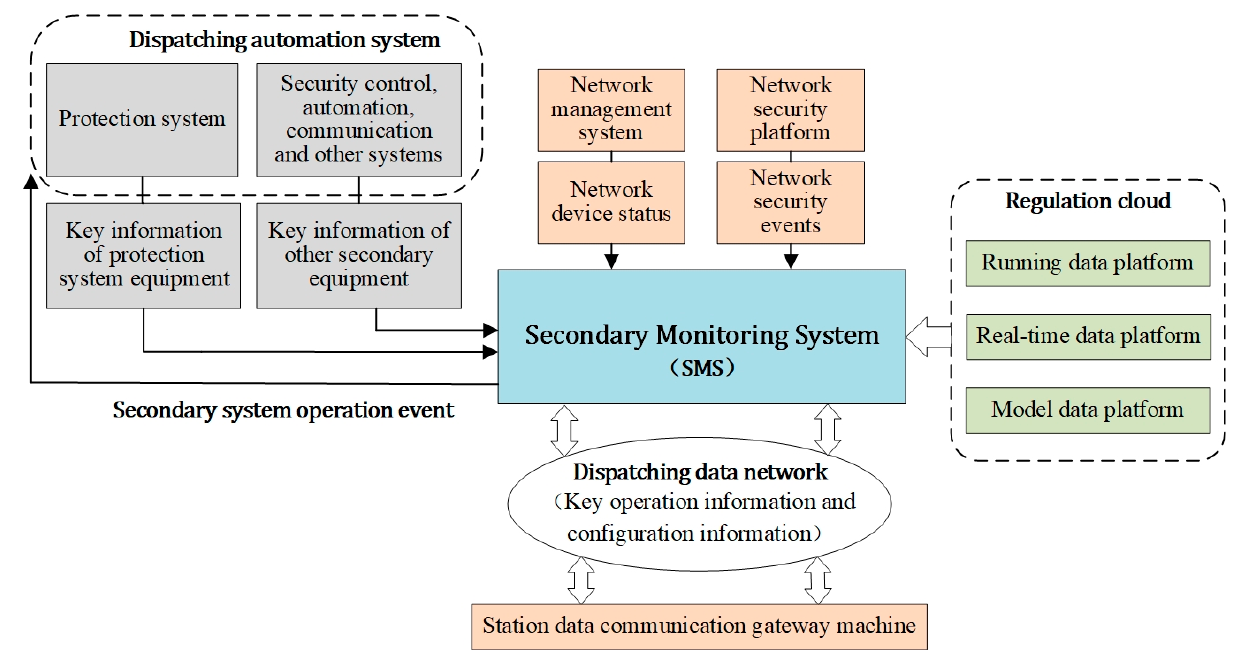
Figure 2. Master station architecture of secondary monitoring system.